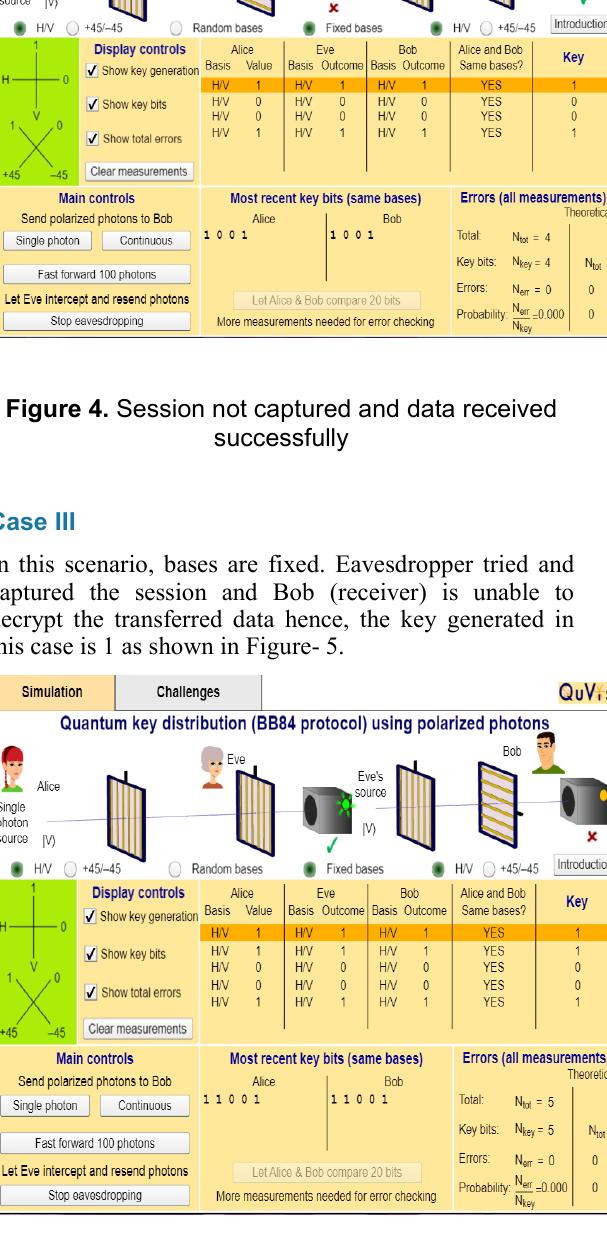
Figure 5. Session captured but data not